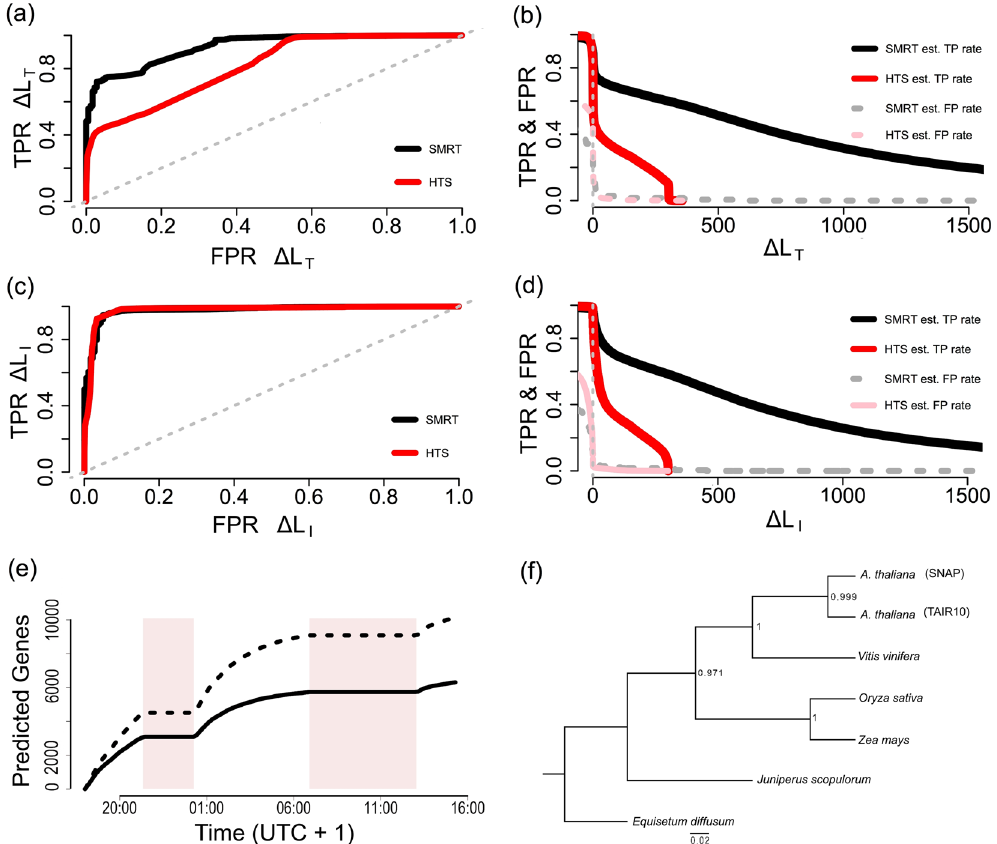
Figure 2. Sample identification and phylogenomics using field-sequenced RTnS data. ( a – d ) Orthogonal species identification using BLASTN difference statistics: HTS data (red) and RTnS (black) matched to reference databases via BLASTN. ( a , c ) Receiver operating characteristic (ROC; estimated false-positive rate vs. estimated true positive rate) and ( b , d ) estimated true- (solid lines) and false-positive (dashed lines) rates. ( a , b ) ∆ L T statistic; ( c , d ) ∆ L I statistic. ( e ) Accumulation curves for ab initio gene models predicted directly from individual A . thaliana reads over time. Count of unique TAIR10 genes (solid line) and total number of gene models (dashed line). Shaded boxes represent periods where the MinION devices were halted while the laboratory was dismantled and moved. ( f ) phylogenetic tree inferred under the multispecies coalescent from RTnS